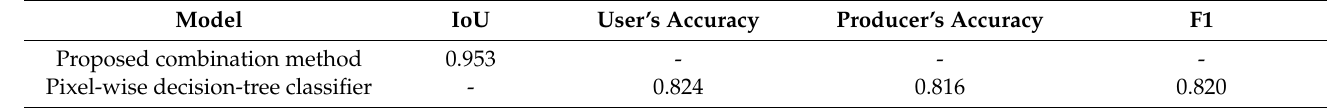
Table 3. Evaluations of rice field mapping